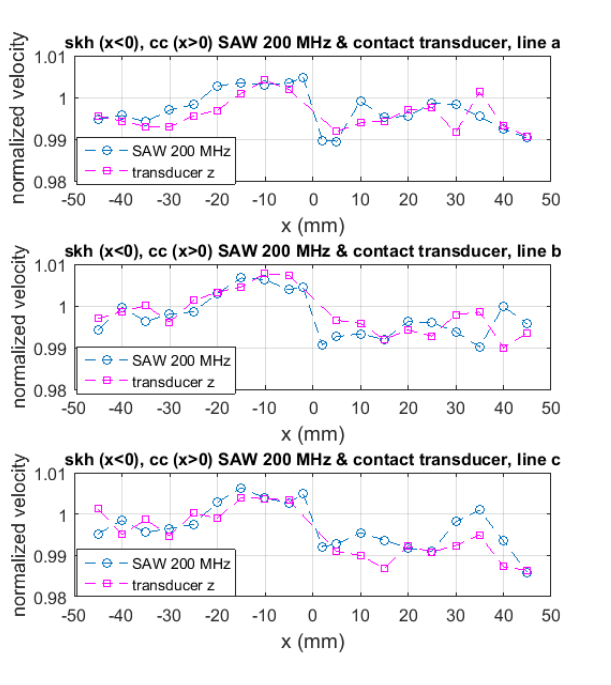
Figure 6. Relative acoustic velocity in z direction based on the measurement with the SAM 200 MHz and the contact acoustic transducer.